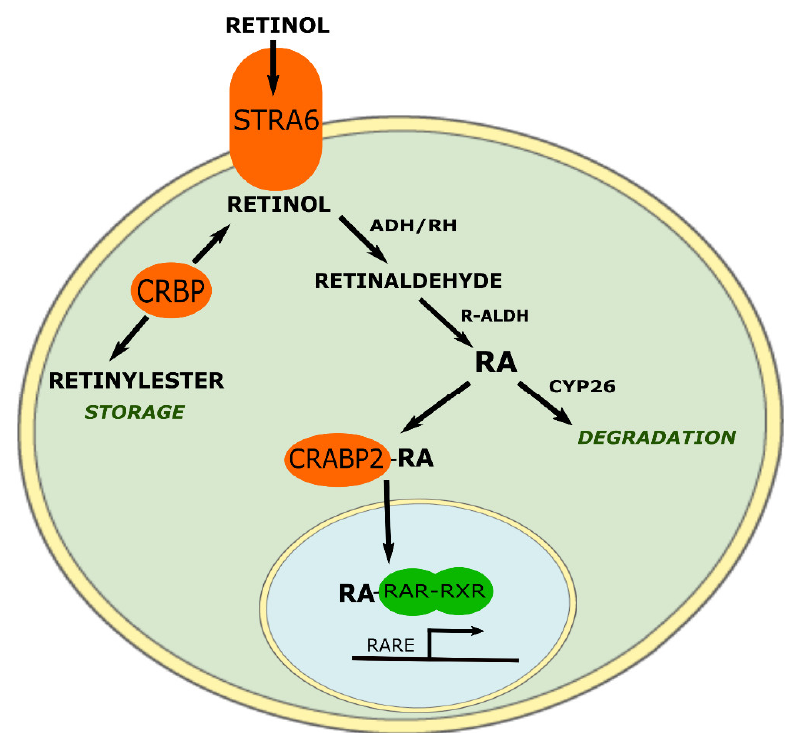
Figure 3. Schematic representation of RA’s signaling via the RAR-RXR pathway. ADH: aldehyde dehydrogenase, CYP26: cytochrome P450 26A1, CRPB: cellular retinol binding protein, CRABP2: cellular retinoic acid binding protein 2, RARE: retinoic acid response element, STRA6: stimulated by retinoic acid 6.